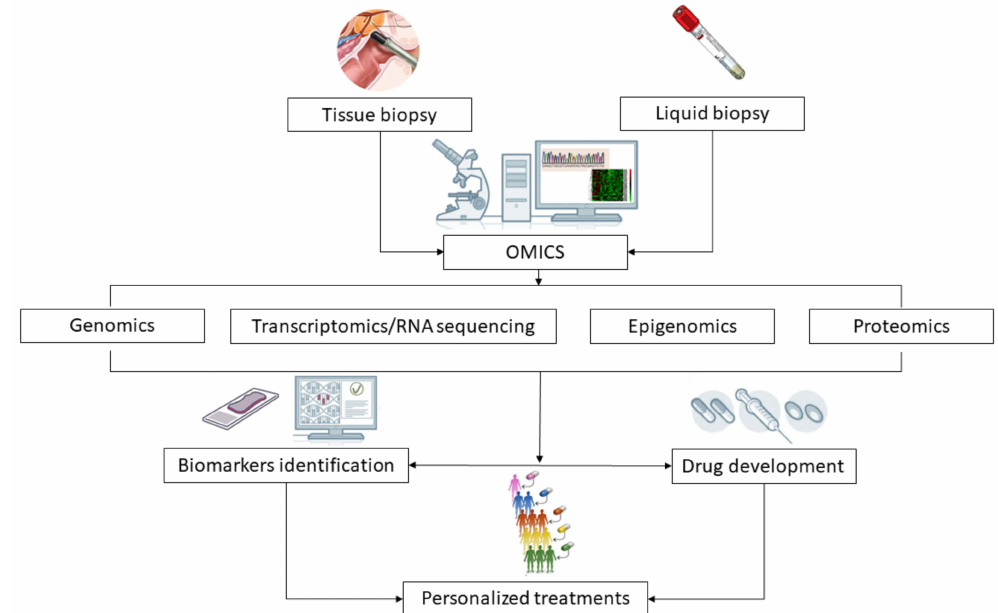
Figure 2. Clinical significance of omics-driven approaches applied to tissue and liquid biopsy analysis in prostate cancer research. The analysis of clinical samples (tissue biopsies, plasma, urine) through the use of novel techniques (such as genomics, transcriptomics, epigenomics and proteomics) allows the identification of prognostic and predictive biomarkers and may guide the development of drugs targeting molecular pathways altered in cancer cells. These advances will contribute to improve patients and treatments selection and to guide personalized interventions for the management of prostate